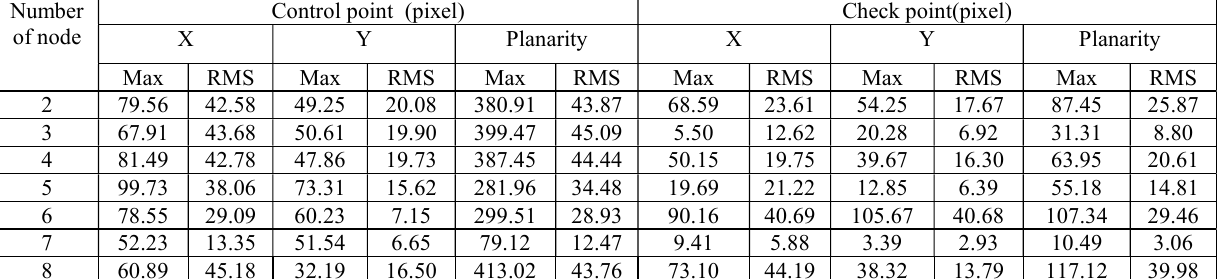
Table 5. Terrain-dependent BP neural network imagery geometrical model accuracy of dataset 1